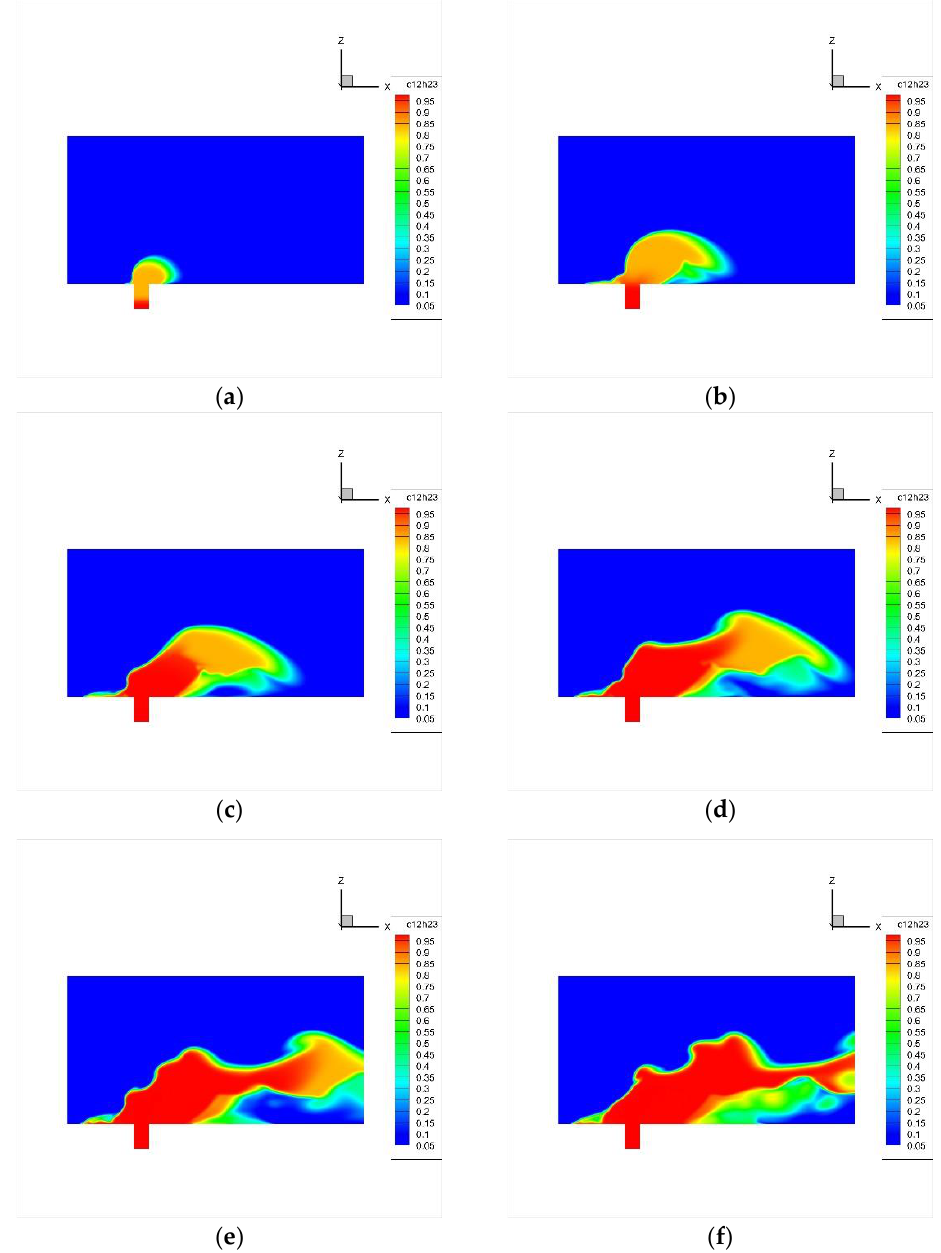
Figure 8. Morphology of supercritical jet in supersonic crossflow: ( a ) t = 2 μ s, ( b ) t = 4 μs, ( c ) t = 6 μs, ( d ) t = 8 μs, ( e ) t = 10 μs, ( f ) t = 12 μs (Case U3 -2).